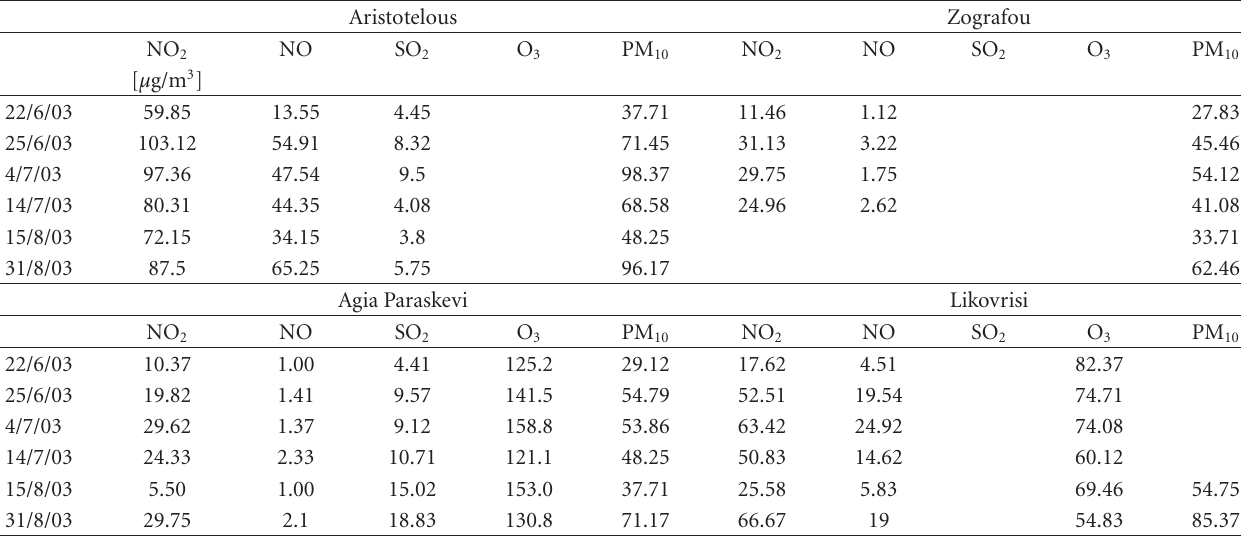
Table 1: Mean daily NO 2 , NO, SO 2 , O 3 , and PM 10 concentrations at each air-pollution monitoring station for all examined days (source: Ministry of Environment, Physical Planning and Public Works,